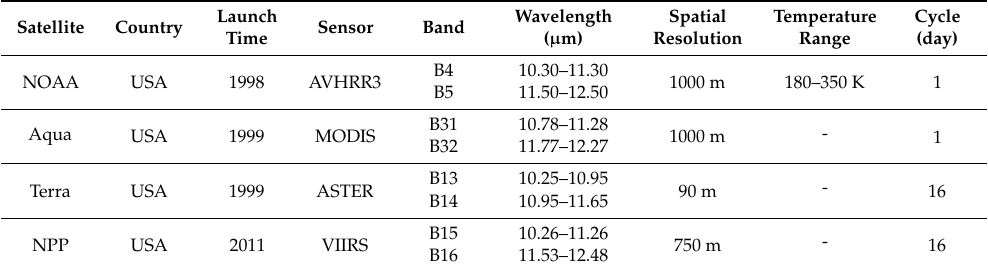
Table 2. Sensor characteristics commonly used for retrieving land surface temperature